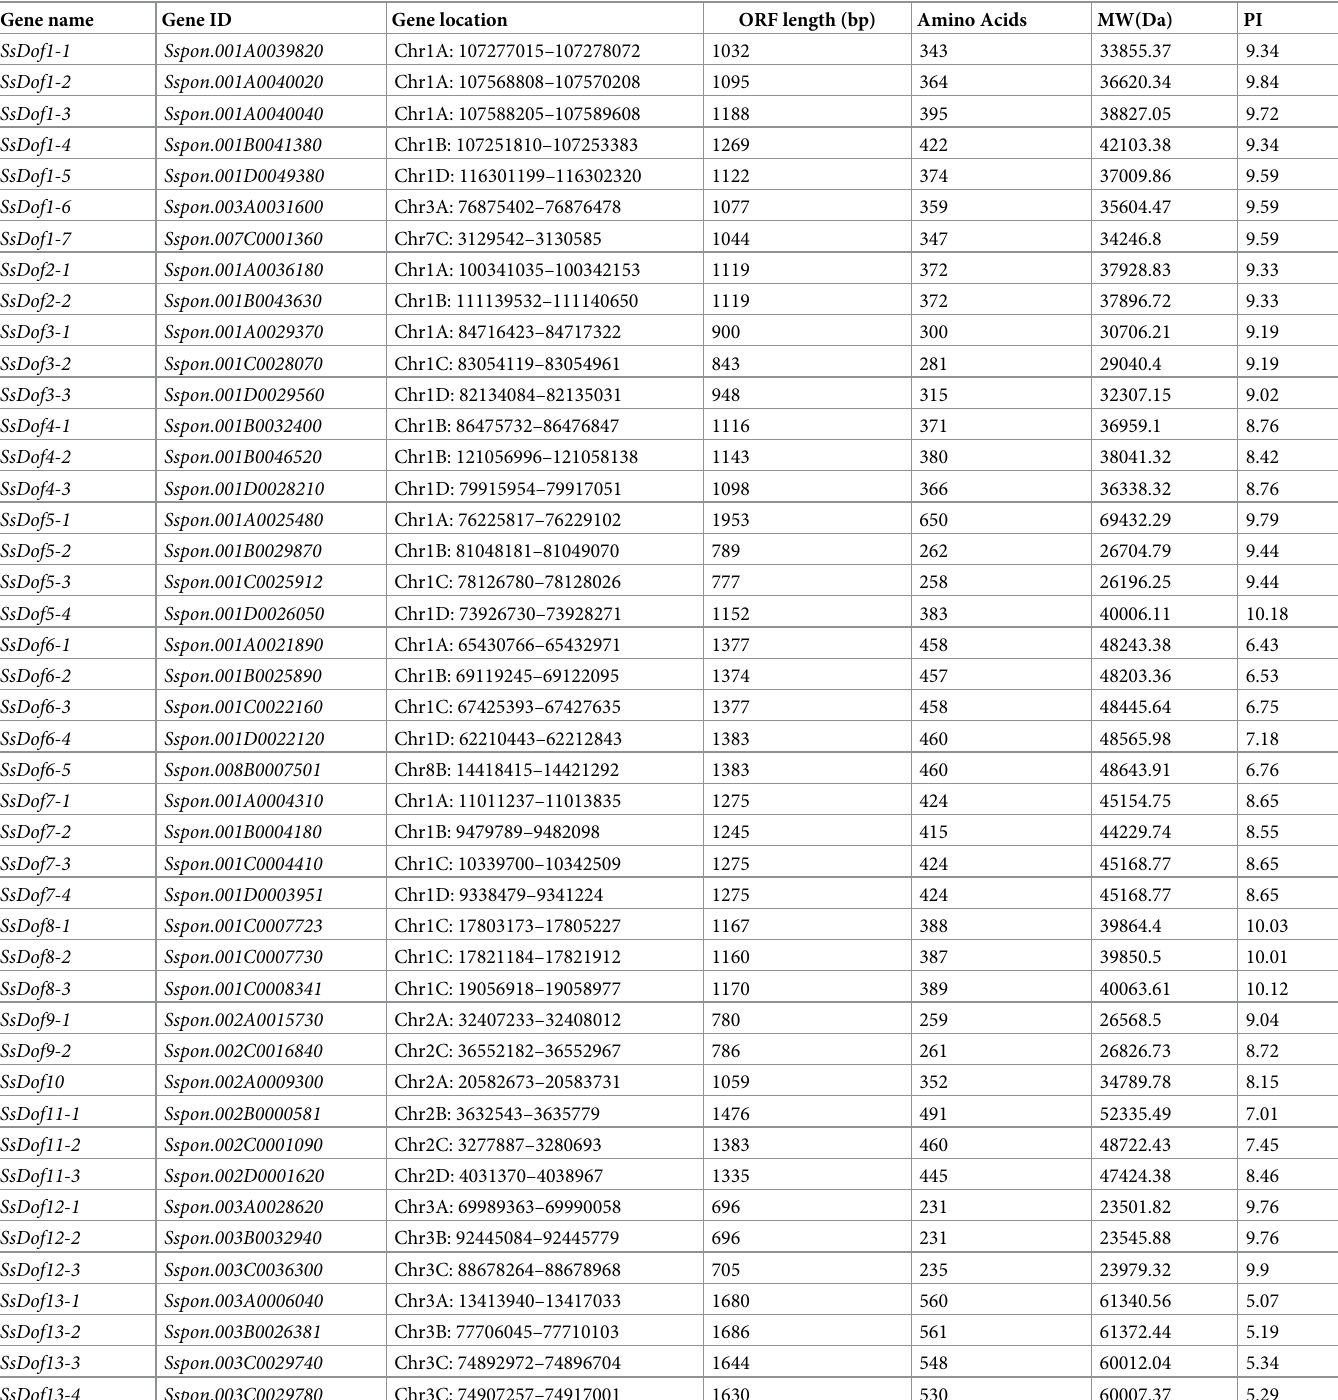
Table 2. Characterization of Dof genes in Saccharum spontaneum